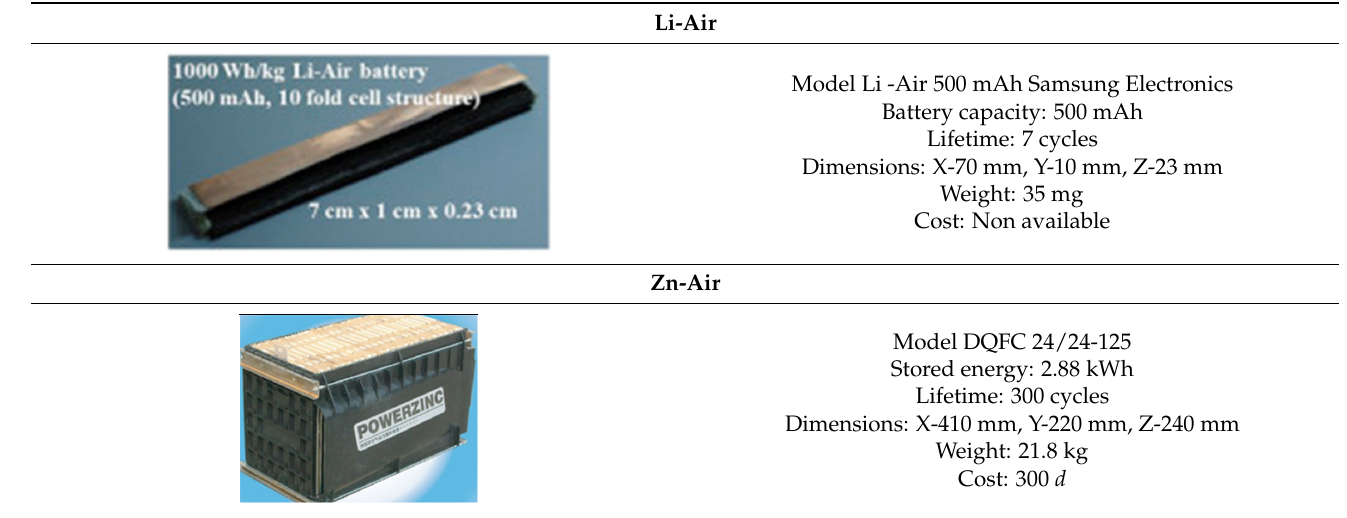
Table A4. Commercial examples of Metal-Air Batteries. Data provided by the manufacturer.